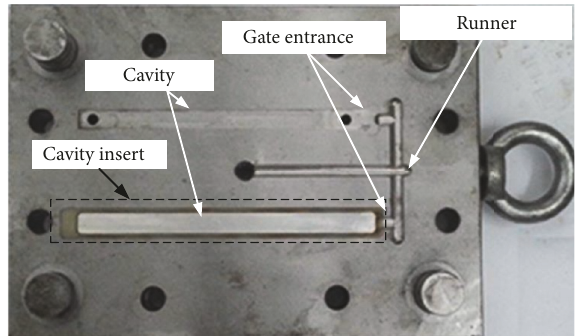
Figure 4: Cavity plate of melt flow length